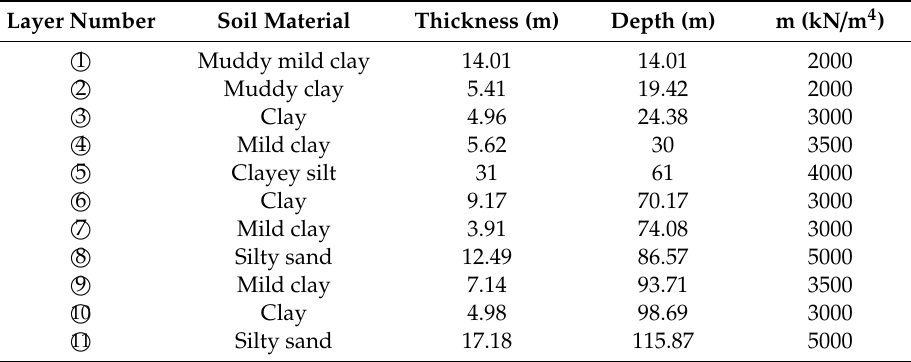
Table 5. Soil layers and initial values of m.